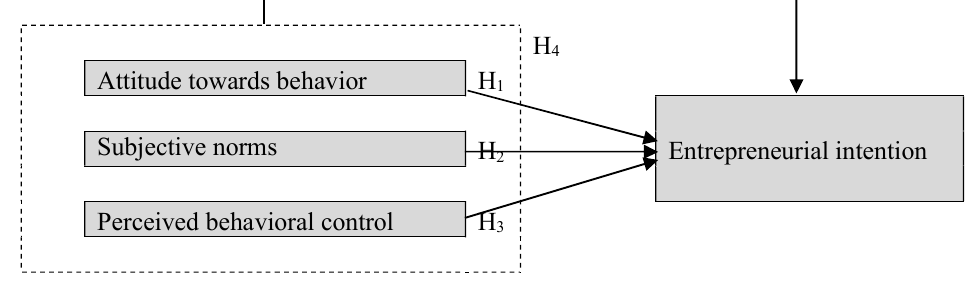
Fig. 1. Research model